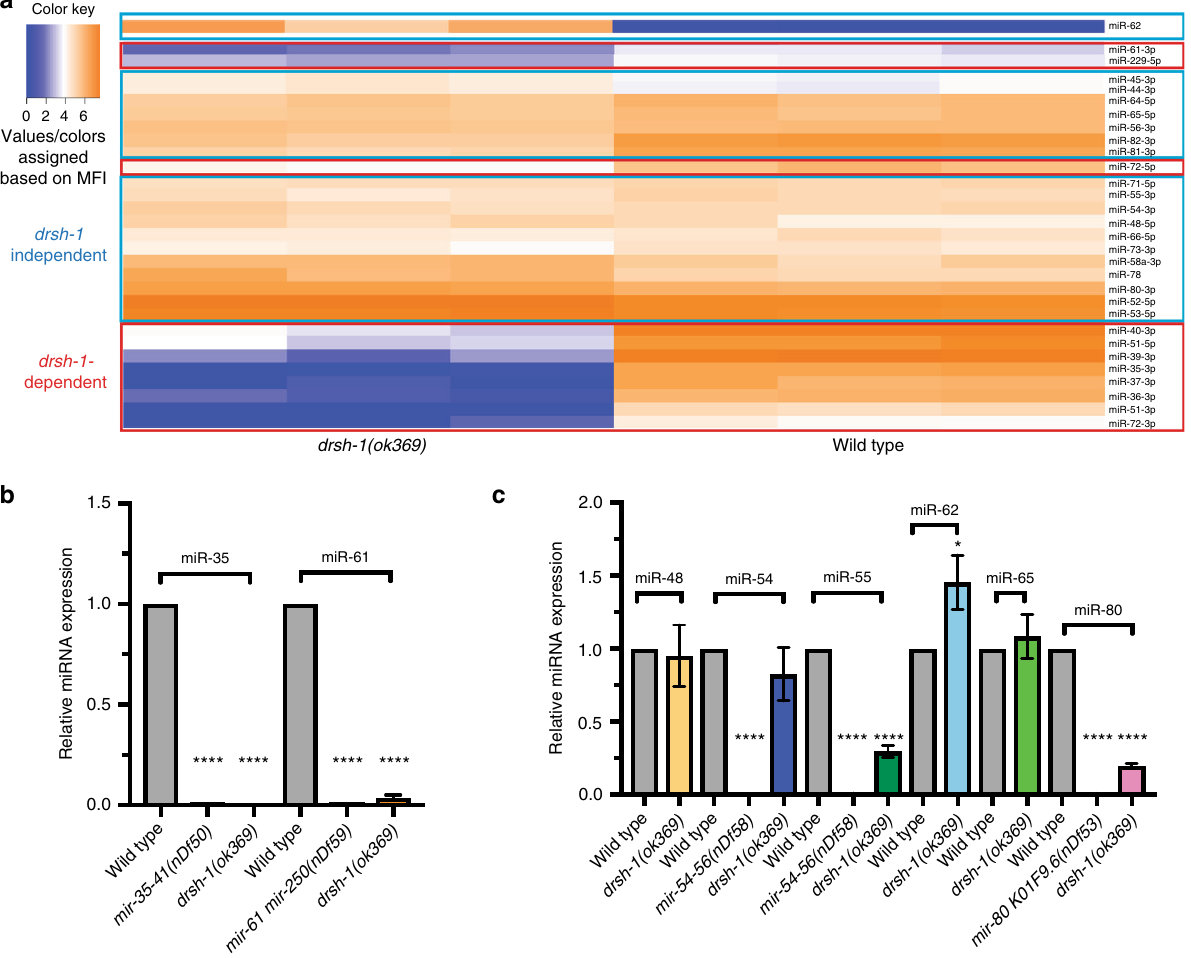
Fig. 1 Germline-expressed miRNAs are largely drosha -independent. a FirePlex ® assay-based heat map analysis of miRNAs on dissected wild-type and drosha(ok369) germlines at 20 °C. Values/colors re fl ect the mean fl uorescent intensity (MFI). Deep blue = low miRNA accumulation. Bright orange = high miRNA accumulation. Red boxes: miRNAs that are reduced in drosha(ok369) germlines termed drosha -dependent. Blue boxes: miRNAs that accumulate in drosha(ok369) were termed drosha -independent. One-hundred dissected gonads were assayed for each genotype in three biological replicates. b , c TaqMan ™ analysis on wild-type, drosha(ok369) and each of the miRNA mutant genotypes at 18 h past L4. drosha -dependent miRNAs do not accumulate in drsh-1 mutants ( b ), while drosha- independent miRNAs are still expressed ( c ). Each TaqMan ™ assay was performed three times on 100 whole worms each time for each genotype. Statistical signi fi cance was calculated by one-way ANOVA with the Bonferroni ’ s correction. **** P < 0.0001. ±